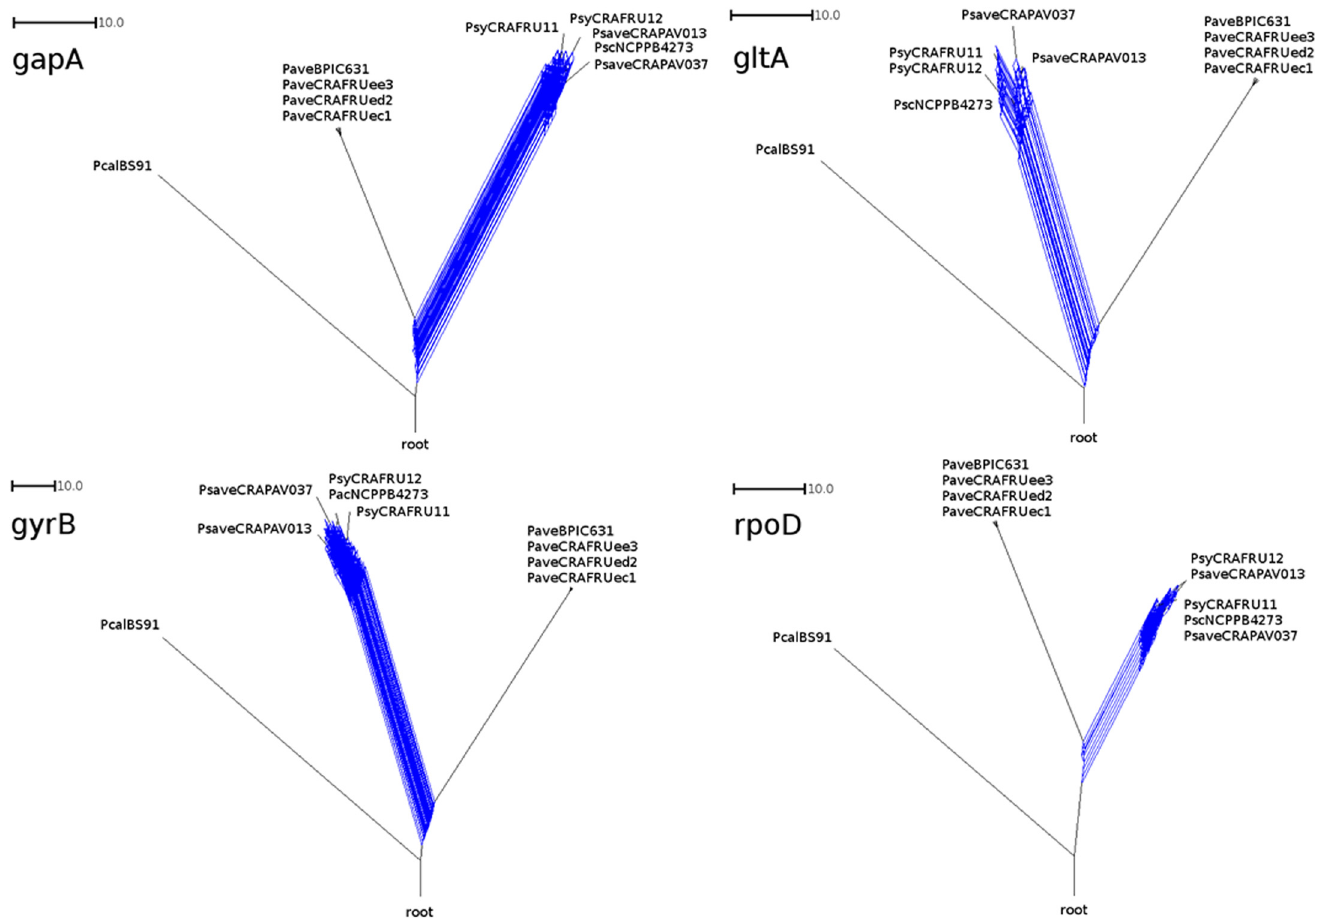
Fig 3. Recombination networks regarding four housekeeping genes of the nine pseudomonad strains infecting Corylus avellana trees. The networks were built using gapA , gltA , gyrB , rpoD genes. Strain legend is shown in Table 1. The scale bar indicates the number of substitutions per nucleotide position. Strong signal of recombination are present solely between the Pseudomonas syringae pathovars. P . cannabina pv. alisalensis Pcal BS91 was included in the analysis as outgroup.